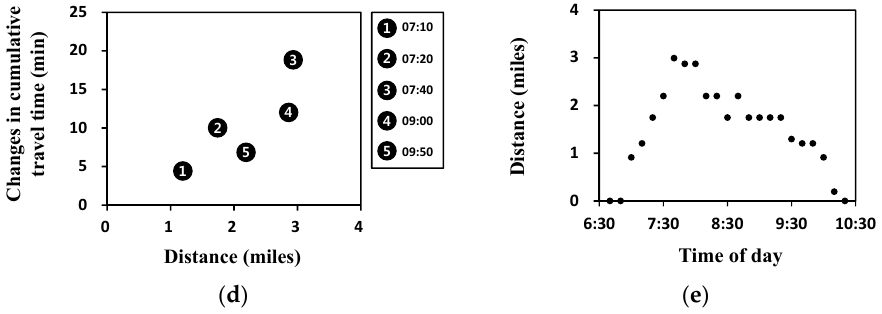
Figure 3. ( a ) Travel time along the 2.87-mile segment near the RSRB (Richmond San Rafael Bridge) toll plaza observed on 15 May. ( b ) Snapshot of cumulative travel time at time 07:10. ( c ) Snapshot of cumulative travel time at time 07:40. ( d ) Changes in cumulative travel time from P to the toll booth. ( e ) Length of the queue.